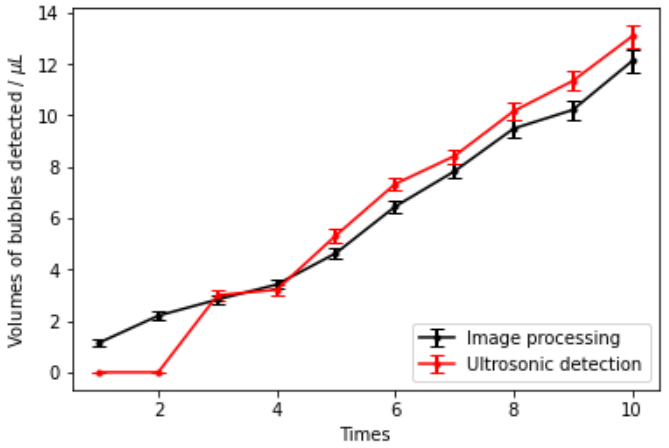
Figure 6. Comparative experiments of the image-processing and ultrasonic-bubble-detection